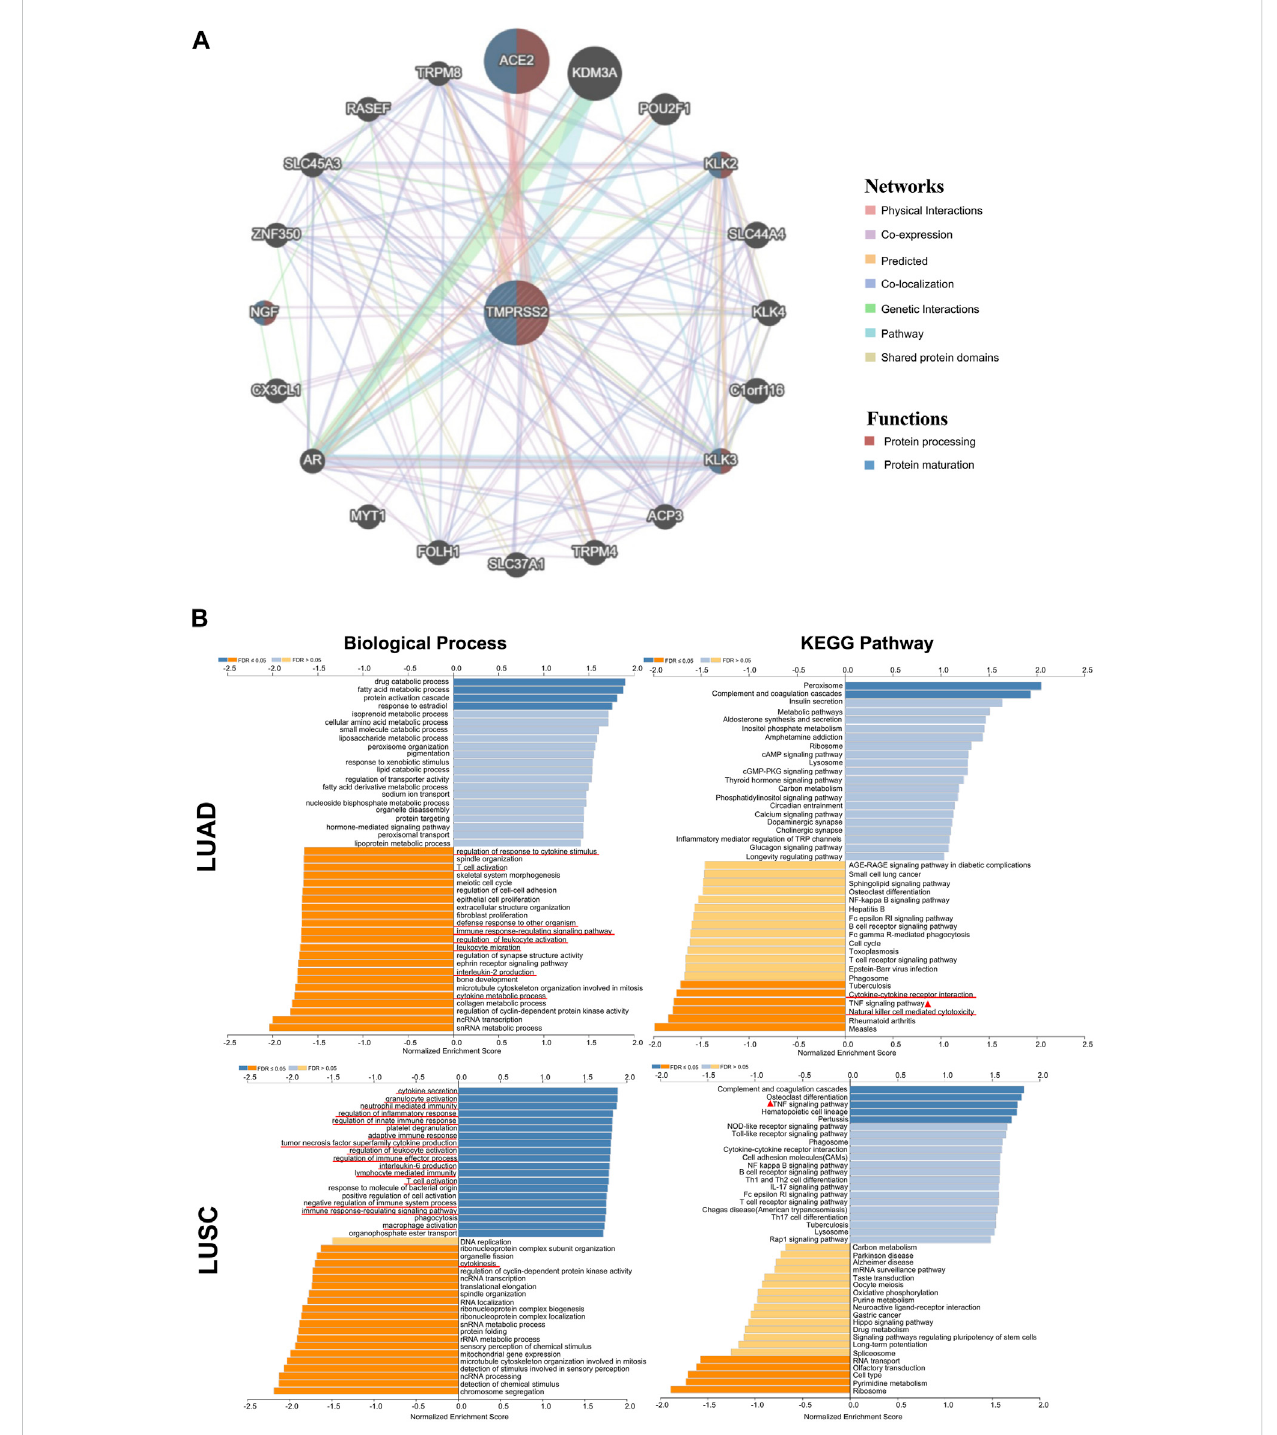
FIGURE 4 TMPRSS2-related gene enrichment analysis by using GENEMANIA and LinkedOmics. (A) Interaction network of TMPRSS2 in TCGA. Lines with different colors represent different bioinformatics methods and different colors in the ring represent diverse functions of the genes. (B) Enriched gene ontology annotations of biological process and KEGG pathway analysis of TMPRSS2-related genes in LUAD and LUSC. Red signi fi es positive and blue signi fi es negative. Light blue and orange signify FDR > 0.05 while dark blue and orange represent FDR ≤